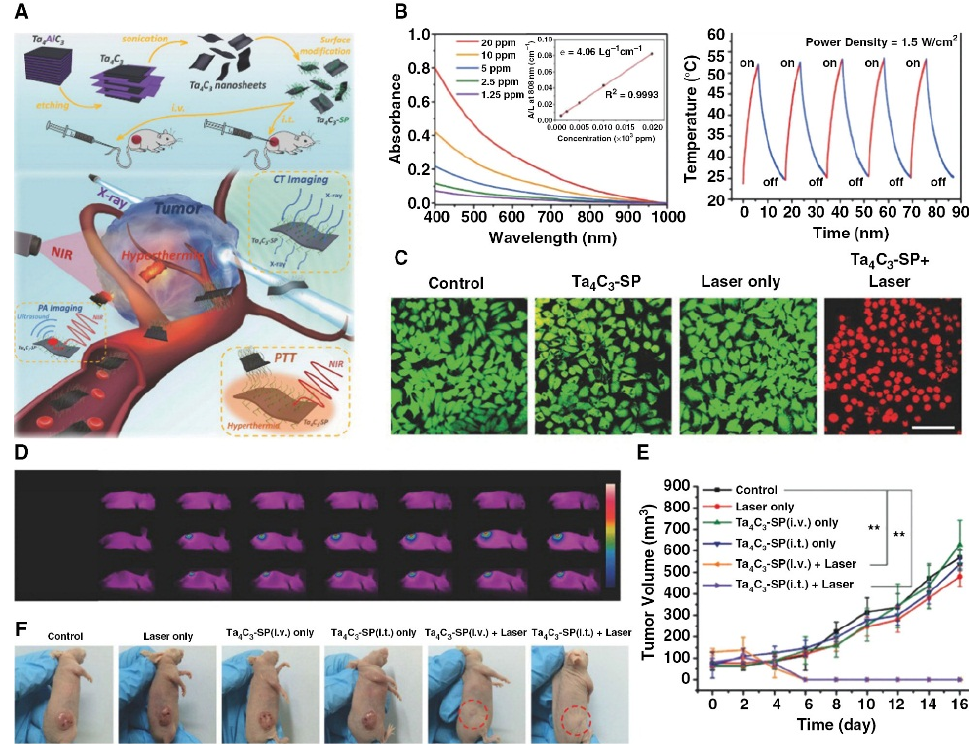
Figure 9. Ta 4 C 3 -SP MXene nanosheets have photothermal treatment effects both in vitro and in vivo. ( A ) Schematic representation of Ta 4 C 3 -SP MXene nanosheets employed in PTT. ( B ) Ta 4 C 3 -SP MXene nanosheet absorbance spectra and photothermal stability after five heating and cooling cycles. ( C ) Confocal fluorescence imaging of in vitro photothermal ablation of 4T1 cells following multiple treatments at 1.5 W cm − 1 (scale bar: 100 m). ( D ) Infrared thermal pictures at the tumor site of 4T1 tumor-bearing mice in control, Ta 4 C 3 -SP (i.v.) + NIR laser and Ta 4 C 3 -SP (i.t.) + NIR laser groups at different time intervals during laser irradiation. ( E ) Tumor growth curves following various treatments. ( F ) Images of tumor-bearing mice following PTT [80].